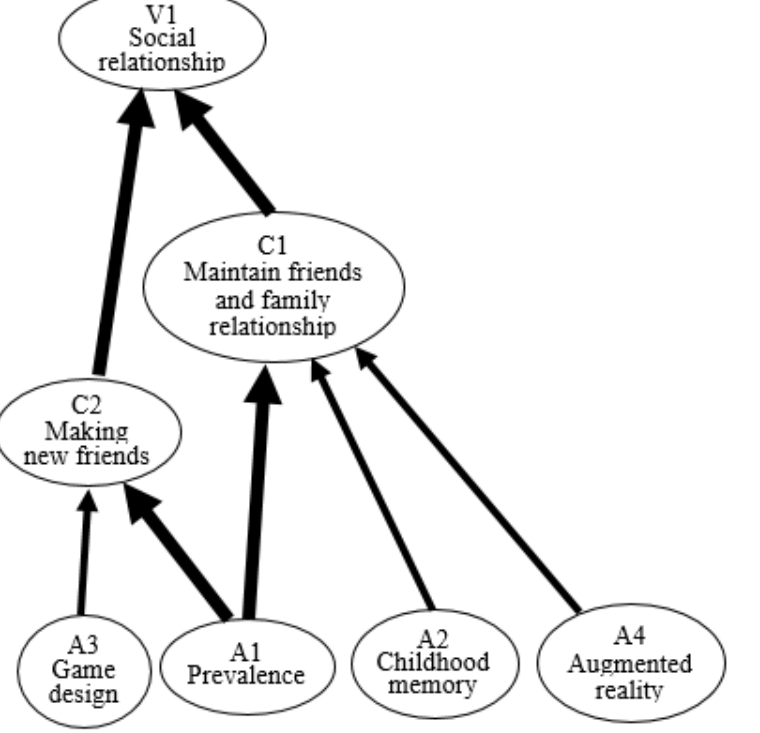
Figure 2. HVM for the social relationship